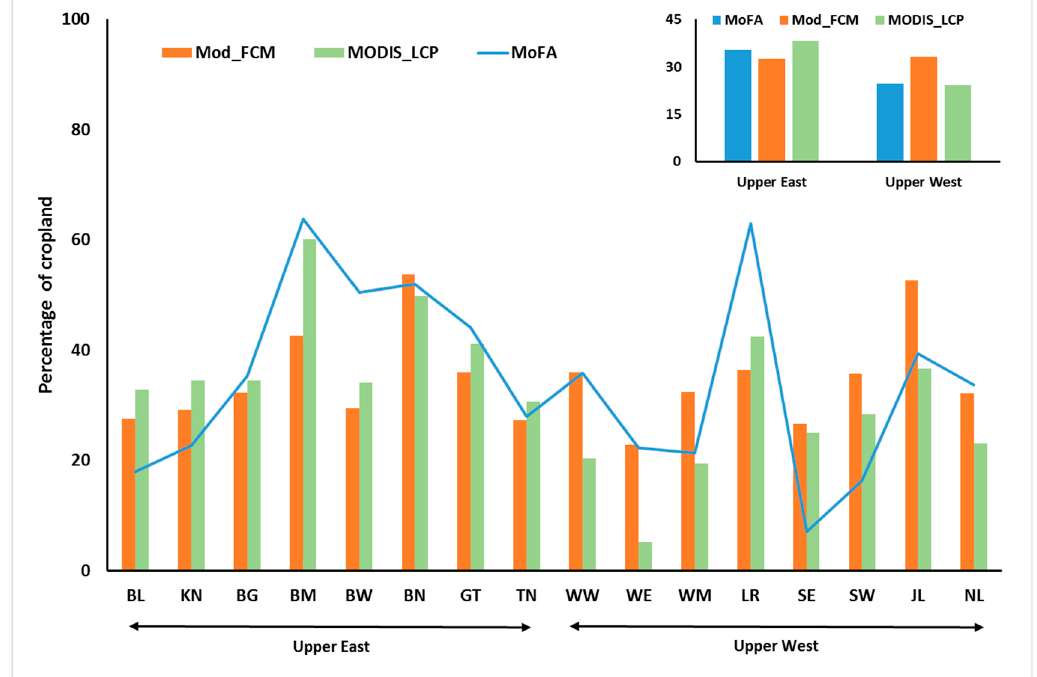
Figure 12. Comparison of cropped area estimates between official government statistics and remote sensing based sources. Definition of district names can be found in Figure 4.